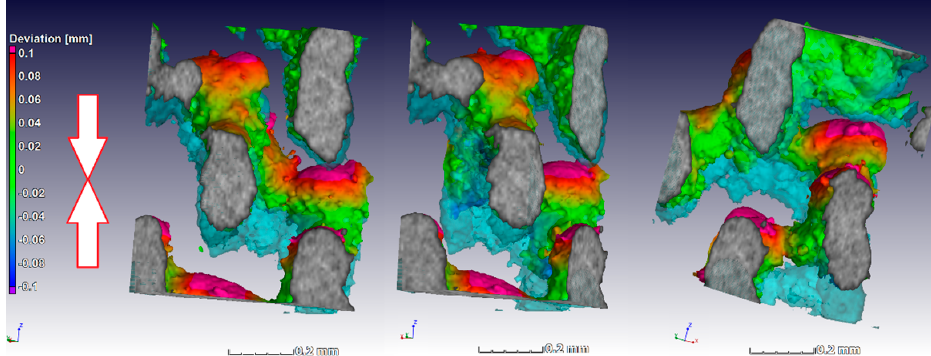
Figure 7 . Three different angular views of the same internal location showing yielding behavior of individual struts and color coding indicating the largest deformation relative to the unloaded state (deformation upwards in image, where the unloaded state is semi-transparent blue). Loading direction is indicated by arrows.